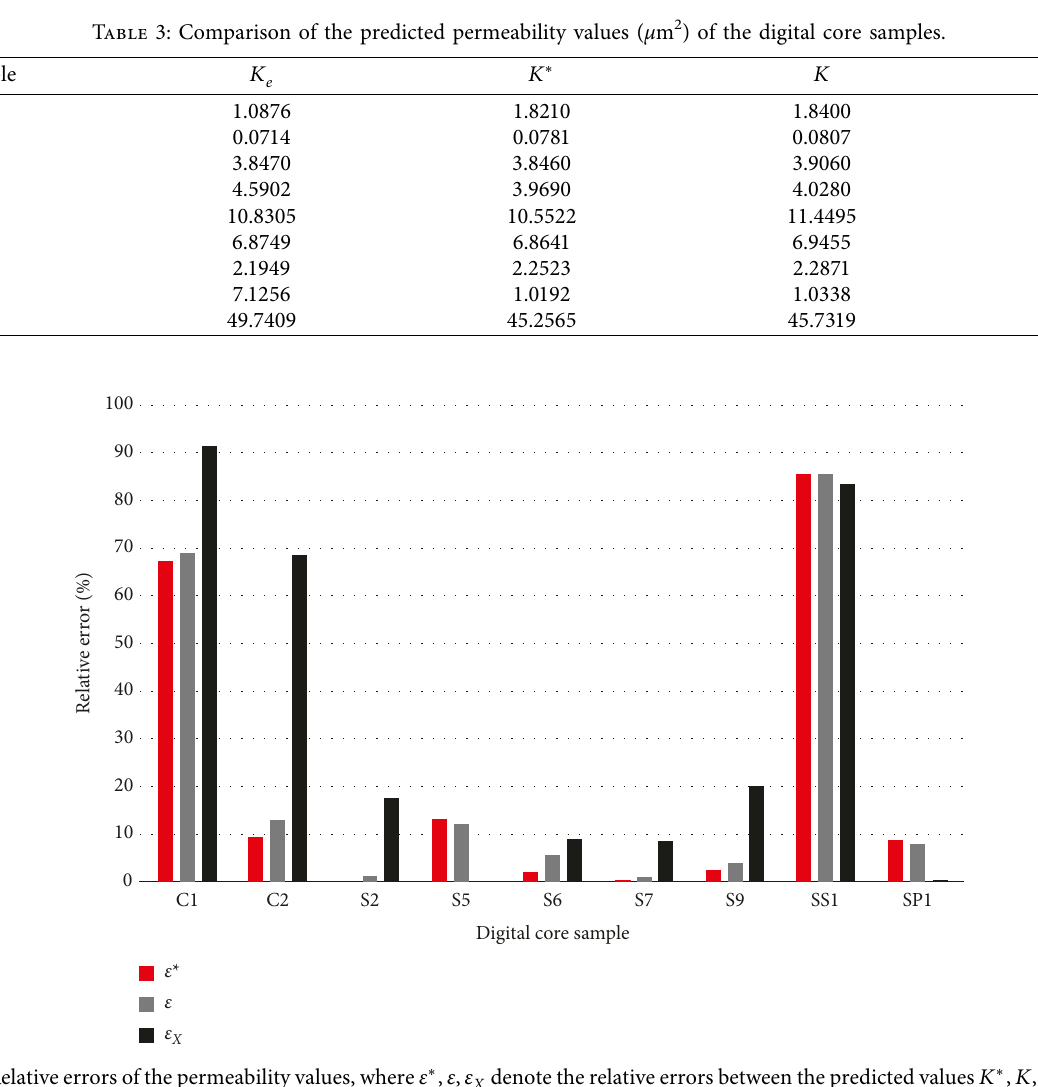
X denote the relative errors between the predicted values